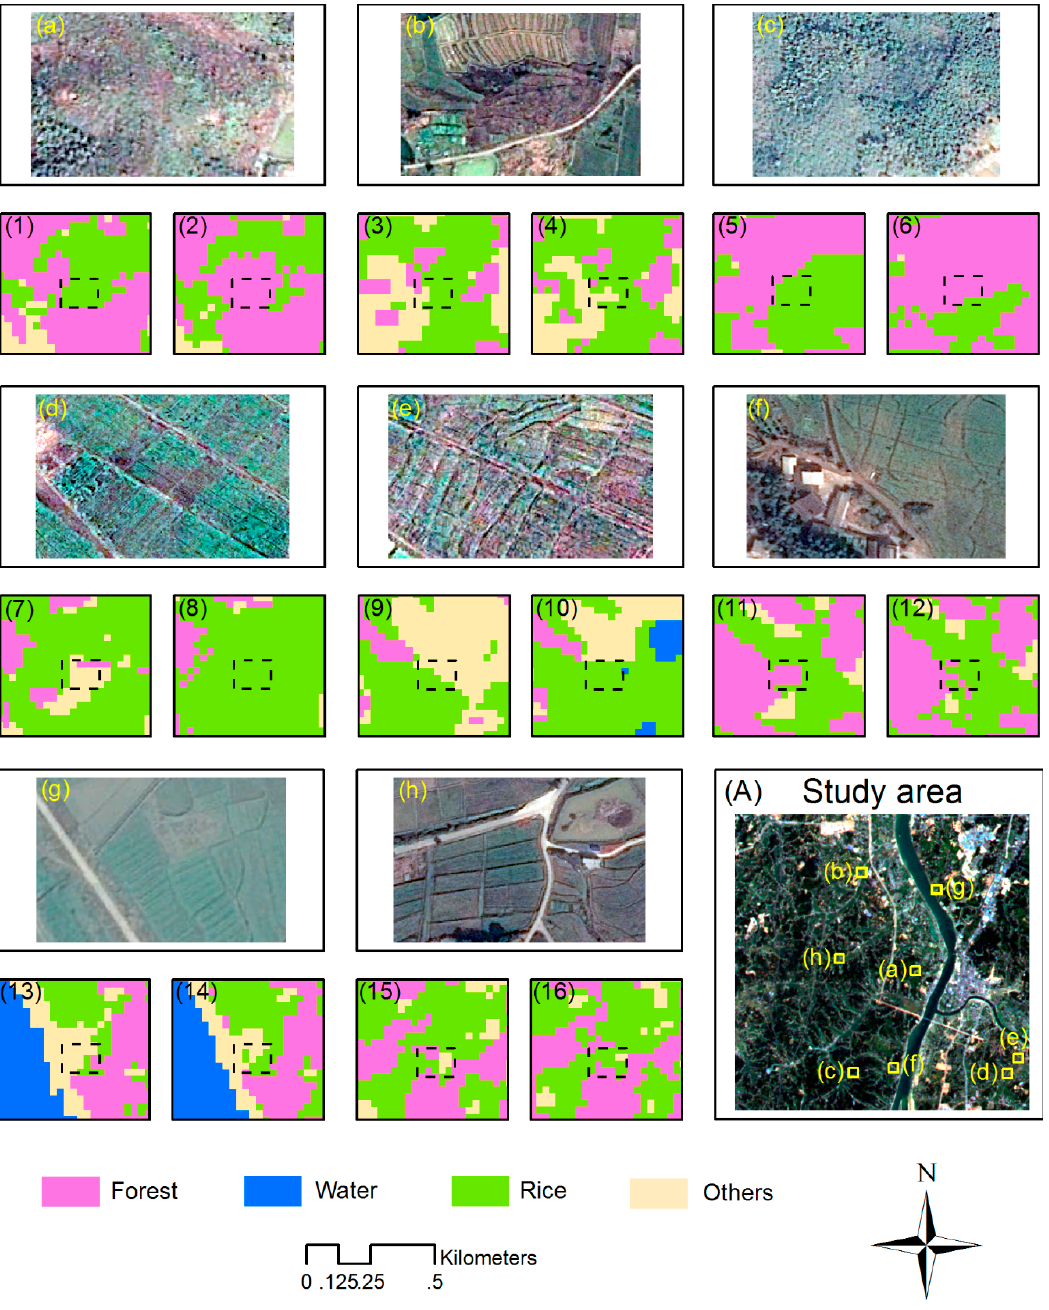
Figure 10. Classification results of eight confusing patches (i.e., ( a – h ), which are observed on Google Earth) based on SVM and CNN; ( 1 , 3 , 5 , 7 , 9 , 11 , 13 , 15 ) are corresponding SVM results of eight patches, respectively; ( 2 , 4 , 6 , 8 , 10 , 12 , 14 , 16 ) are produced by CNN; ( A ) Location of eight regions.